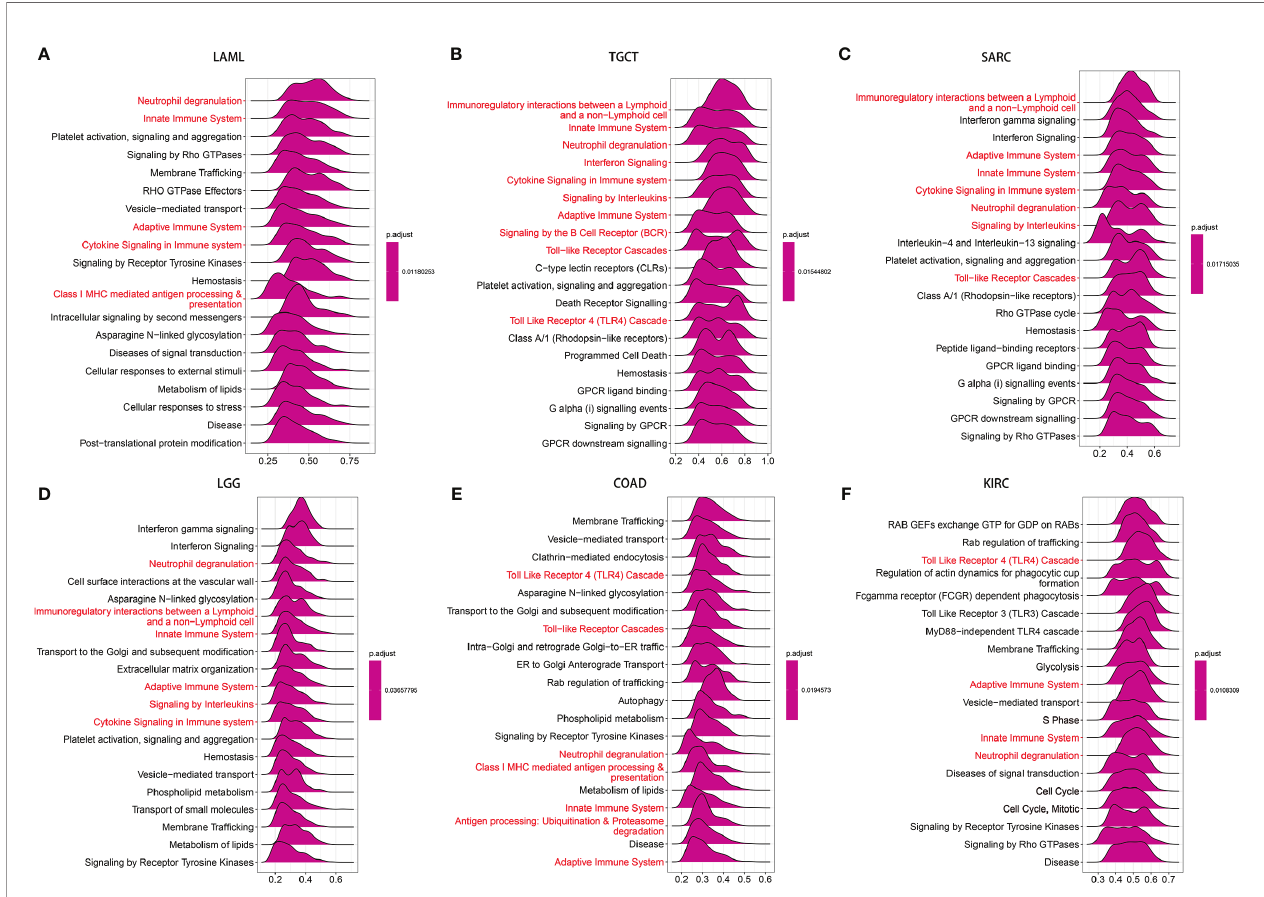
FIGURE 8 | GSEA of NAAA in pan-cancer. (A – F) TOP20 GSEA terms in indicated tumor types. Red indicates immune regulation-related